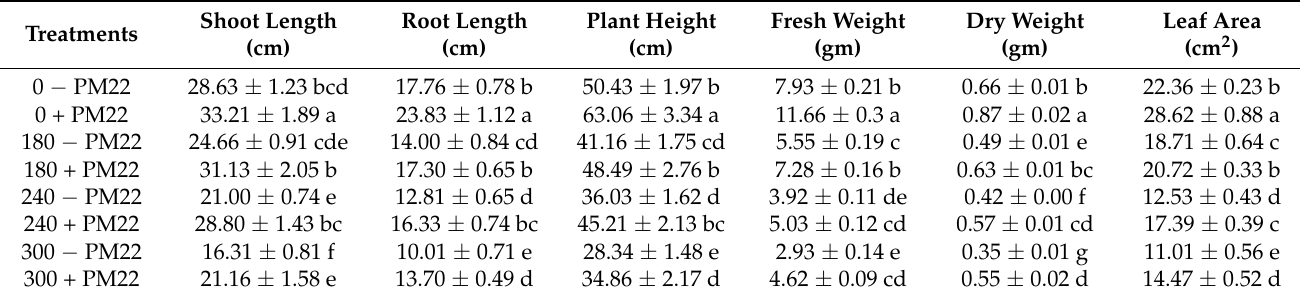
Table 1. Impacts of various treatments on morphological traits of PM22-inoculated maize at different salt stress levels (0, 180, 240, and 300 mM). Soil containing non-inoculated and soil with seeds inoculated with B. Safensis (PM22) were the two treatments. The values are the averages of three triplicates with standard errors of the mean. Lowercase letters indicate significantly different values ( p = 0.05) from each other, according to Tukey’s least significant difference test.